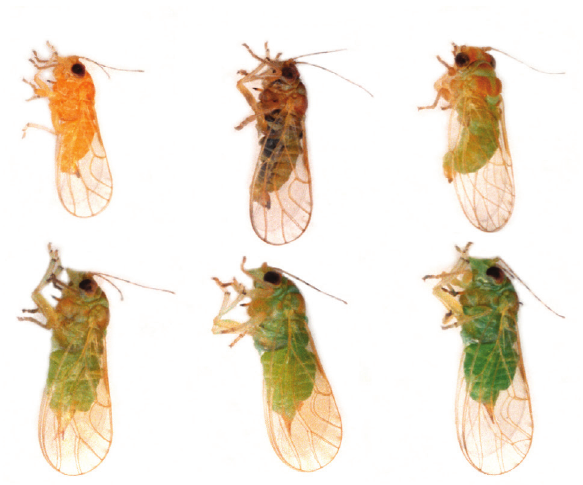
Figura 3 . Danos provocados por Isogonoceraia divergipennis em folhas de Poincianella